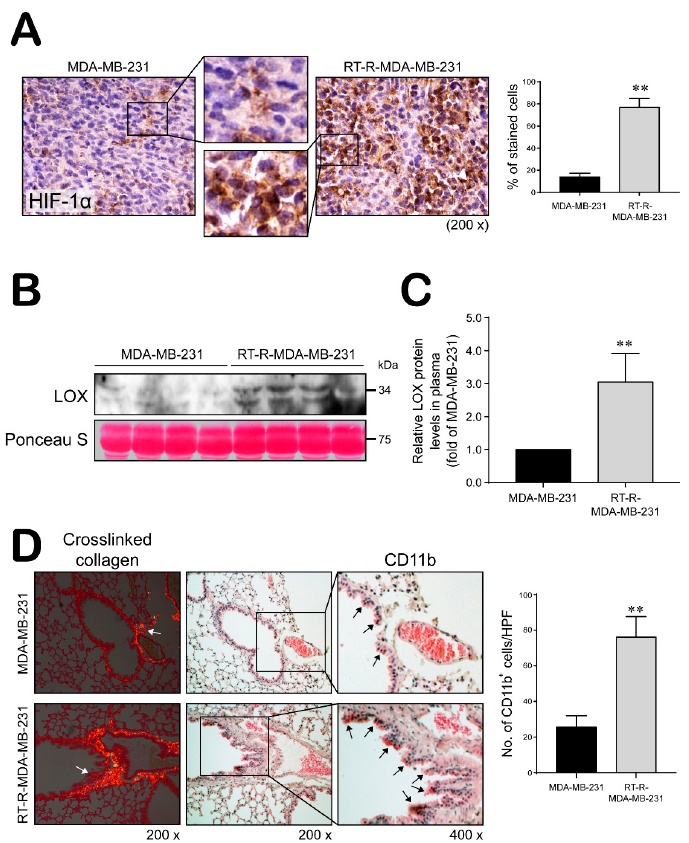
Figure 5. RT-R-MDA-MB-231 cell-injected mice increased HIF-1 α levels and LOX secretion, and premetastatic niche formation. ( A ) HIF-1 α levels detected in tumor section by immunohistochemistry (magnification; ×200 and ×400). Data represent mean values ± SEM ( n = 10). ** p < 0.01 compared with the MDA-MB-231-injected mice. ( B , C ) Secreted LOX levels were detected in the plasma by western blotanalysis. Data represent mean values ± SEM ( n = 8). ** p < 0.01 compared with the MDA-MB-231-injected mice. ( D ) Lung tissue sections from MDA-MB-231- and RT-R-MDA-MB-231-injected mice were stained with Picrosirius Red to analyze crosslinked collagen. Recruited CD11b + -immunoreactive bone marrow-derived dendritic cells (BMDCs) near the sites of collagen cross-linkage were stained with anti-CD11b antibody. White arrows indicate representative crosslinked collagen fibers. Black arrows indicate recruited CD11b + BMDCs (magnification; × 200 and × 400). Data represent mean values ± SEM ( n = 10). ** p < 0.01 compared with the MDA-MB-231-injected